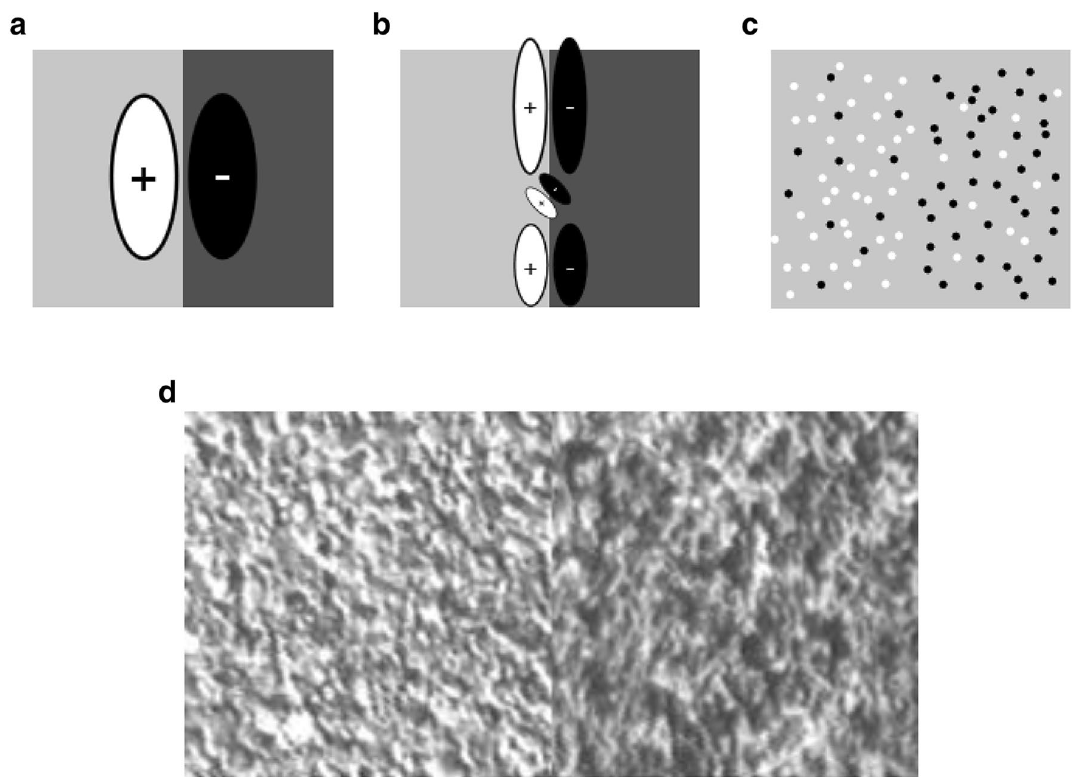
Figure 1. Boundaries without luminance step edges. ( a ) A luminance step boundary (LSB) and a simple detection model in which a linear Gabor filter measures the regional luminance difference. ( b ) Model similar to that in ( a ) where the LSB is analyzed by multiple Gabor filters at varying spatial scales. ( c ) Example of luminance texture boundary (LTB). The luminance difference is defined by differing proportions of black and white micropatterns on each side of the boundary, with no sharp luminance change at the boundary. ( d ) Two juxtaposed textures from the Brodatz database. Although there is clearly a regional difference in luminance, there is no sharp luminance change at the